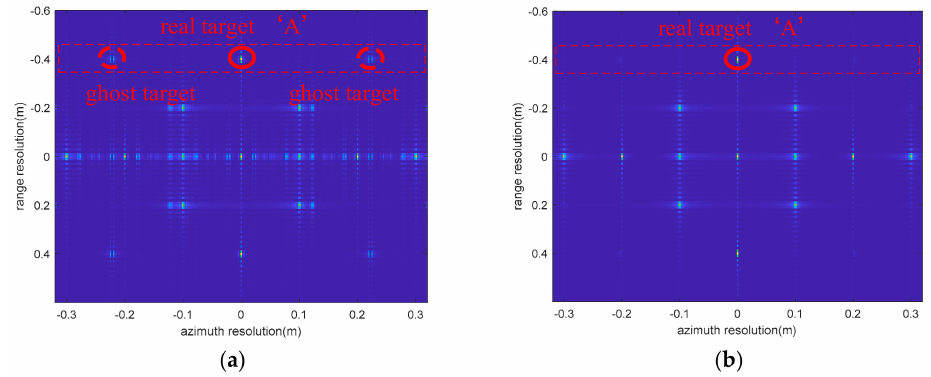
Figure 18. Imaging results without ( a ) and with ( b ) compensation under condition